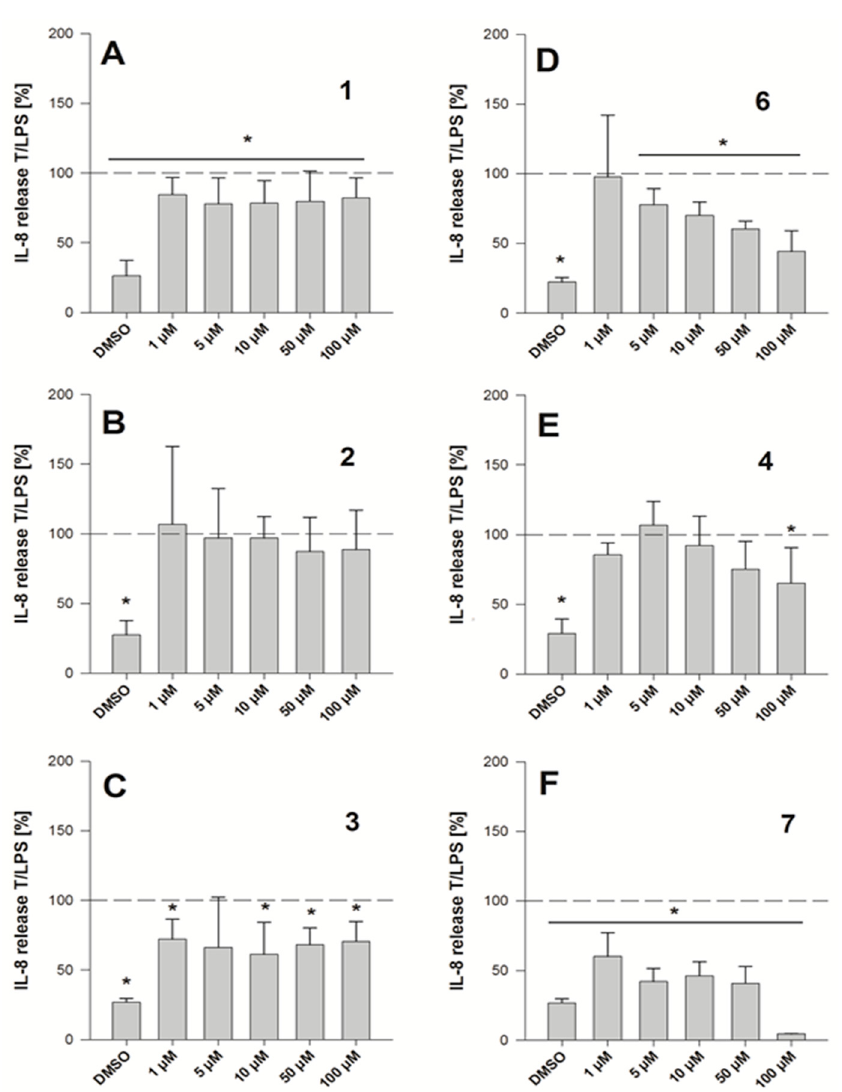
Figure 4. IL-8 release by HGF-1 cells expressed as test over pg LPS control (%) for compounds 1 – 4 , 6 , and 7 ( A – F ) upon 6 h of co-incubation; data are depicted as average ± SD, n = 3–4, technical replicates = 3, *significant differences to pg LPS control ( p < 0.05, Student’s t -test) .